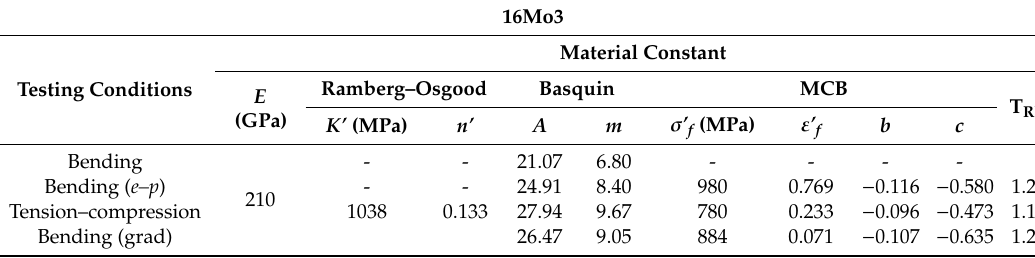
Table 6. Cyclic properties of 16Mo3 steel.